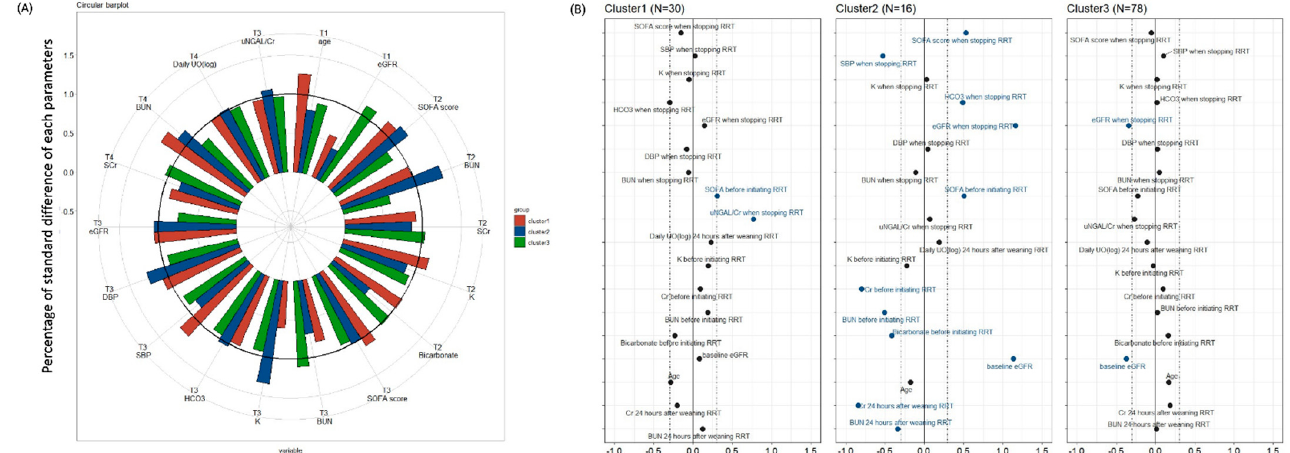
Figure 3. ( A ) Circular barplots of the selected predictors associated with each cluster. The height of each bar represents each percentage of standard difference to total standard difference response of each characteristic. ( B ) Three clusters based on 18 parameters . Manhattan plot of the standardized differences across three AKI subgroups of the selected baseline predictors. The x axis is the standardized difference value, and the y axis represents the four time serial baseline parameters. The dashed-dotted vertical lines represent standardized difference cutoffs of >0.3 or < − 0.3. The light blue horizontal lines sort the category to which the predictors belong, including T1 (baseline), T2 (before initiating RRT), T3 (at the time of stopping RRT) and T4 (24 h after weaning off RRT). Abbreviations: AKI, acute kidney injury; BUN, blood urea nitrogen; Cr, creatinine; eGFR, estimated glomerular filtration rate; NGAL, neutrophil gelatinase-associated lipocalin; RRT, renal replacement therapy; sCr, serum creatinine; SOFA, Sequential Organ Failure Assessment; UO, urine output.